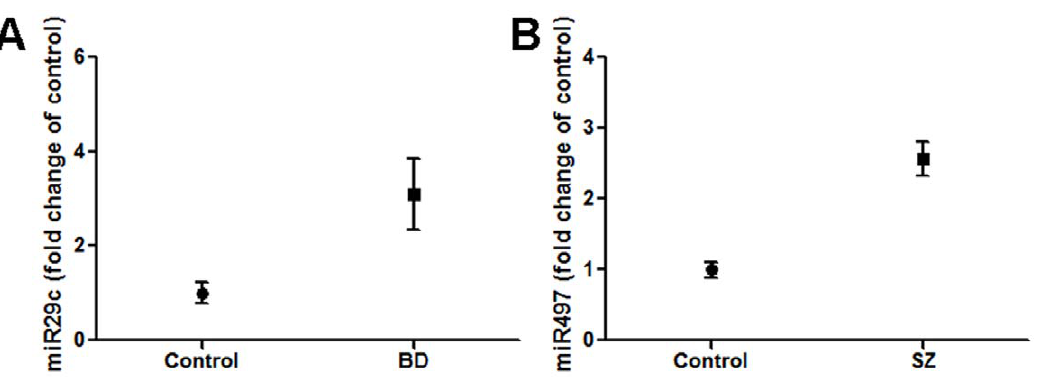
Figure 5. In comparison to controls, the expression of miR-29c and miR-497 is significantly increased in BD and SZ samples, respectively. Average exosomal RNA extracted from BA9 cortices of BD samples show a 2.77 fold increase of miR-29c in comparison to controls (A). SZ samples reveal 2.35 fold increase of miR-497 when compared to controls (B). Error bars indicate S.E.M.